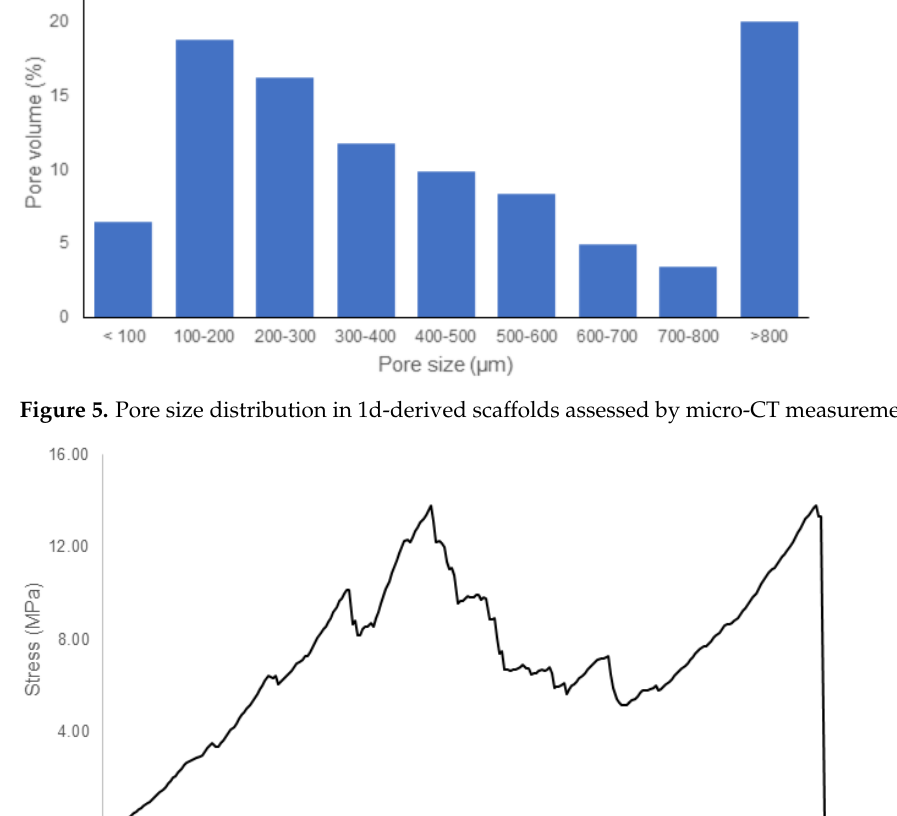
Figure 5. Pore size distribution in 1d-derived scaffolds assessed by micro-CT measurement.